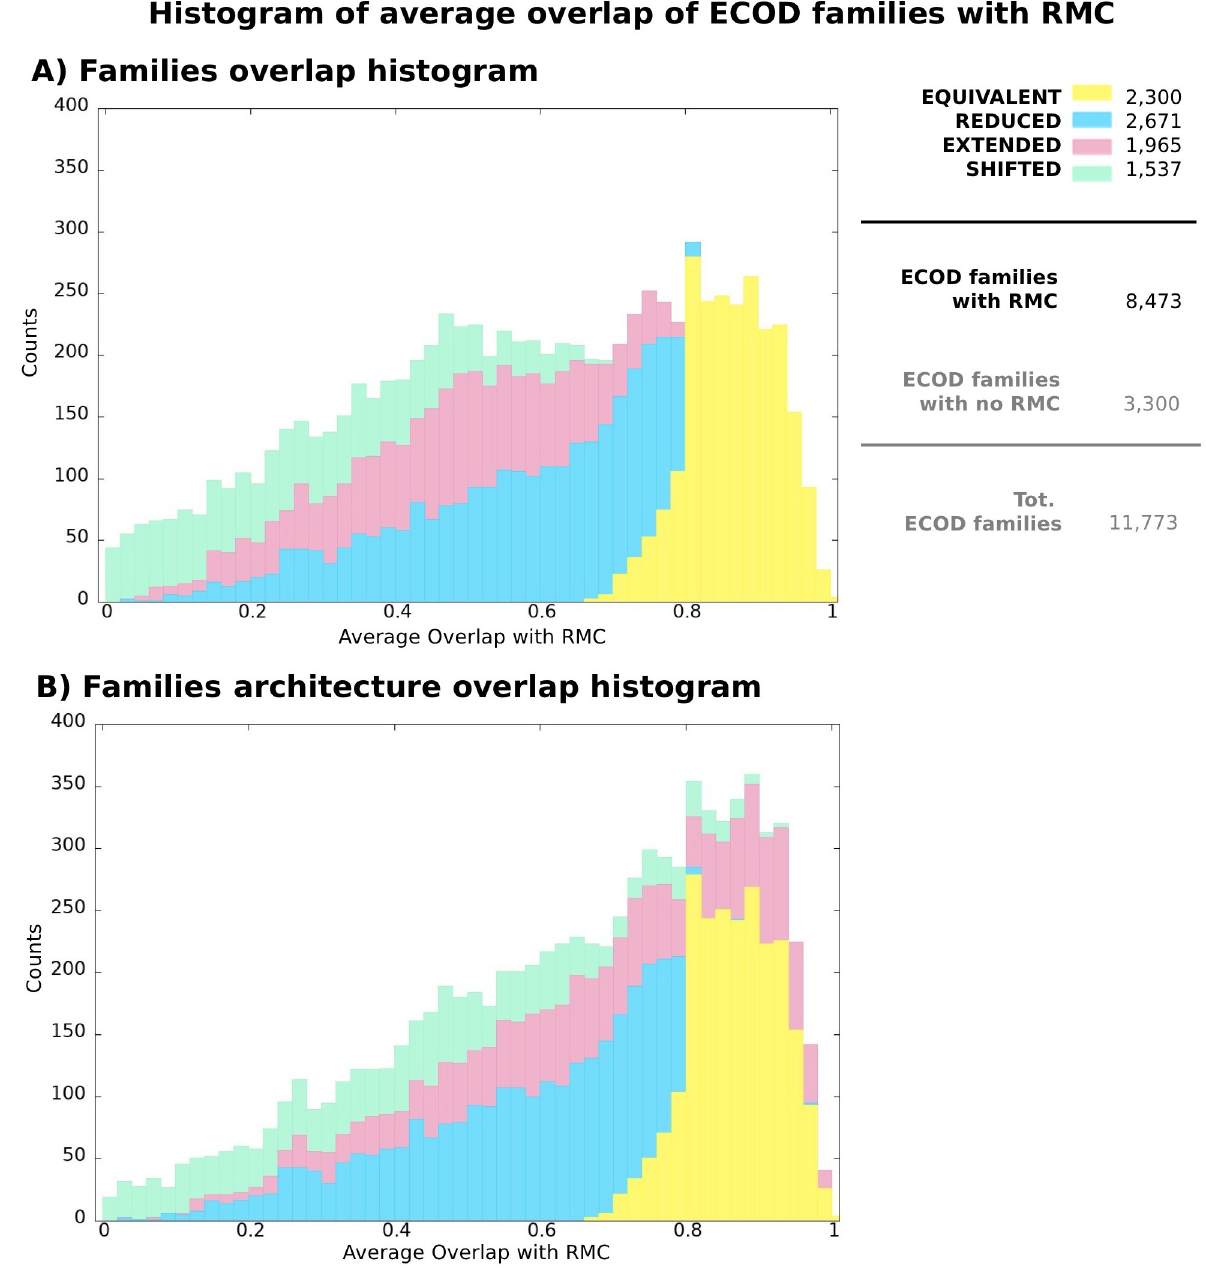
Fig 7. Histograms showing average overlap between ECOD families and their representative MCs. Colors reflect the contribution of each MC category to each bin (equivalent, reduced, extended and shifted, see S1(B) Fig and Methods for definitions). A : Overlap between individual ECOD families and their representative MCs (cfr. with Fig 6) B : Overlap between individual ECOD families or architectures and representative MCs. Given an ECOD family and its representative MC (same pairs as in A), we search for a better overlap of the representative MC with any multi-family architecture featuring the original ECOD family and up to two additional families. The reported average overlap value is thus the best between the overlap with the original family and any other such ECOD architecture. Note that the ECOD architecture labels (equivalent/reduced/extended/ shifted) are still assigned according to the representative MC overlap to the original ECOD family so as to show to which extent the overlap in each MC category increases with respect to A).